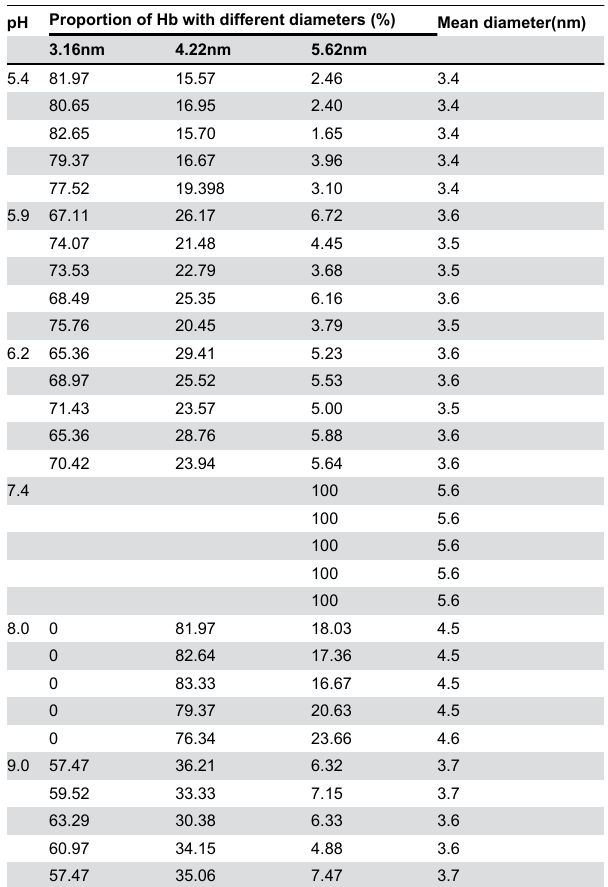
pH Proportion of Hb with different diameters